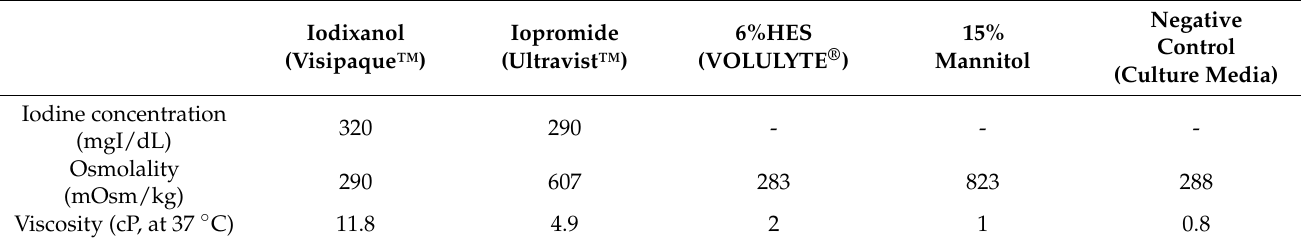
Table 1. Characteristics of test solutions.